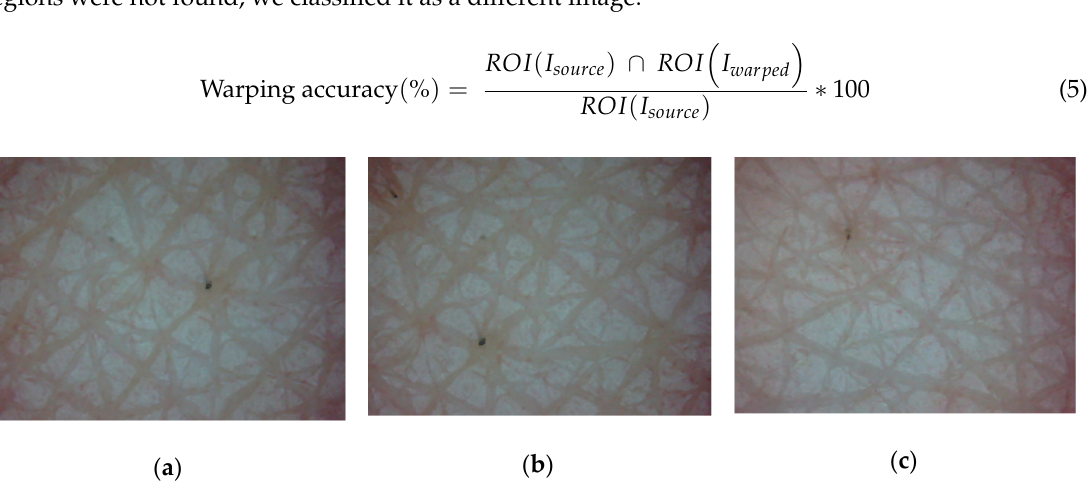
Figure 10. Examples of skin dataset—( a ) source image; ( b ) warping regions existing; ( c ) warping regions not existing.